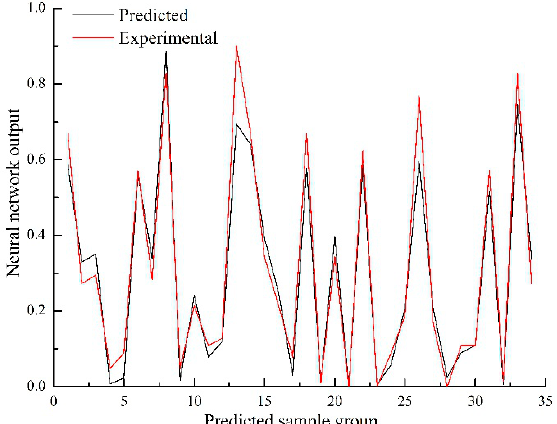
Figure 5. Training regression graph of BP neural network.